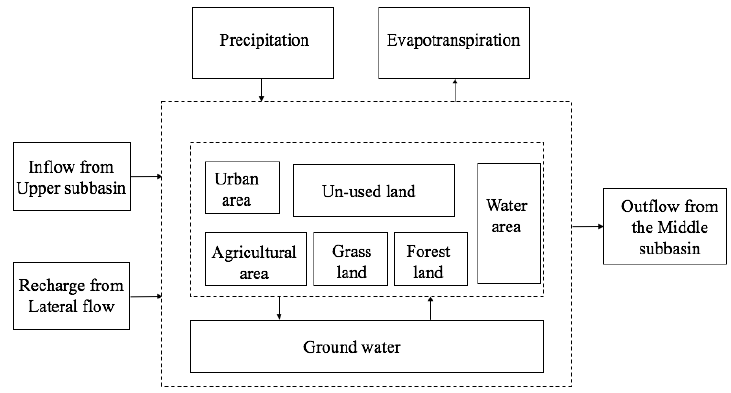
Figure 4. The structure of the concept water balance model for the middle reach.